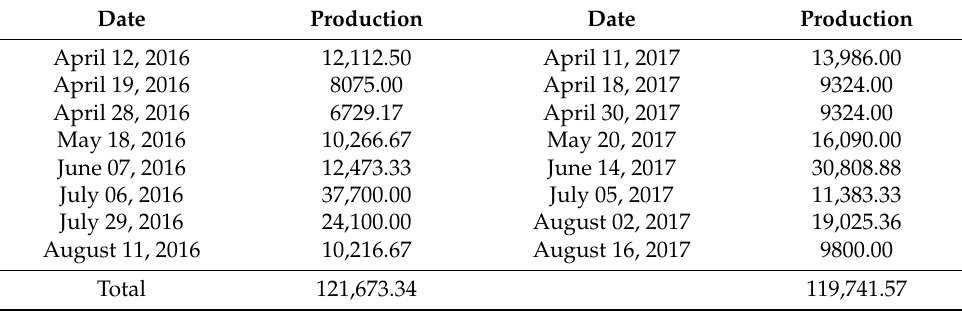
Table 1. Production per m 2 for the years 2016 and 2017 in kg ha − 1